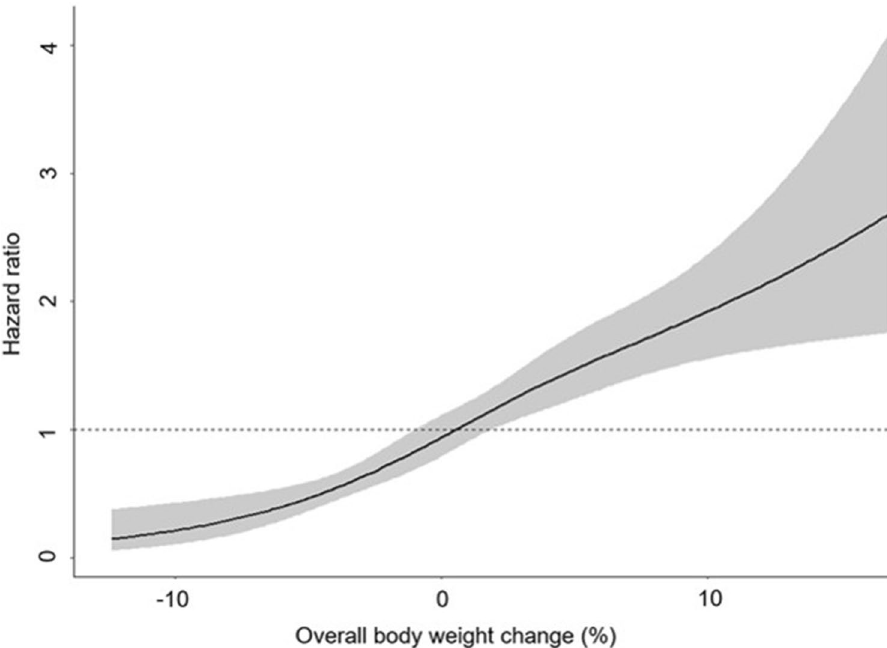
Figure 1. The hazard ratio plot showing the correlation between overall body weight change and risk of incident NAFLD. The models were fitted with restricted cubic splines with 4 knots placed at the 5th, 35th, 65th, and 95th percentiles of overall body weight change (model selection and knot placement via Bayesian information criterion) and the curves were adjusted for variables in a multivariate model including age, sex, hypertension, diabetes, waist circumference, body mass index, ALT, triglyceride, high density cholesterol and total cholesterol. NAFLD, nonalcoholic fatty liver disease; ALT, alanine